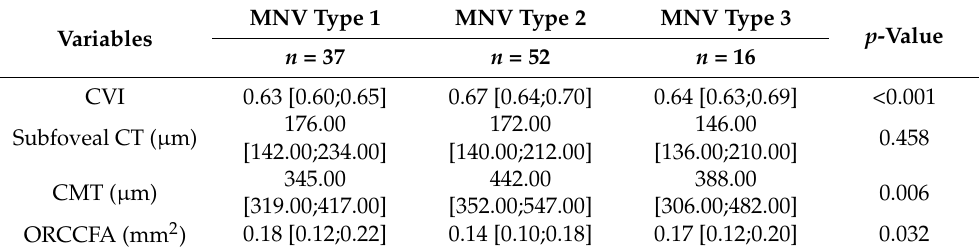
Table 2. Summary descriptive statistics expressed by median value (q1 = first quartile; q3 = third quartile) and absolute frequency (%) by groups of MNV (1, 2, 3) for the ophthalmologic parameters. The p -value was derived from Kruskal–Wallis H test.